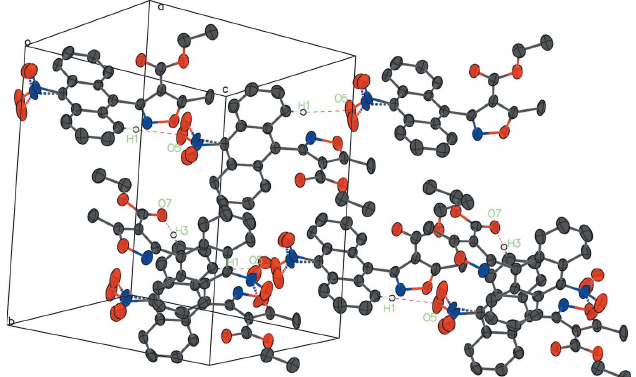
Figure 4 The partial packing of compound (I). For clarity, only hydrogen bonds C1—H1 (cid:3)(cid:3)(cid:3) O5 i and C3—H3 (cid:3)(cid:3)(cid:3) O7 ii are shown as dashed lines, and H atoms not involved in these hydrogen bonds are removed.